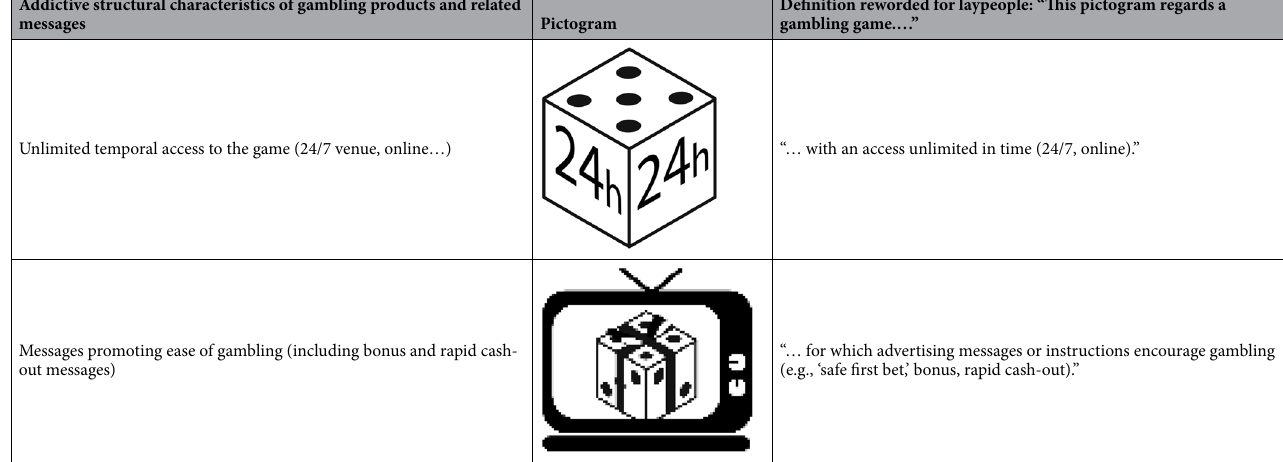
Table 1. Final 10 pictograms and their reworded definitions for laypeople.